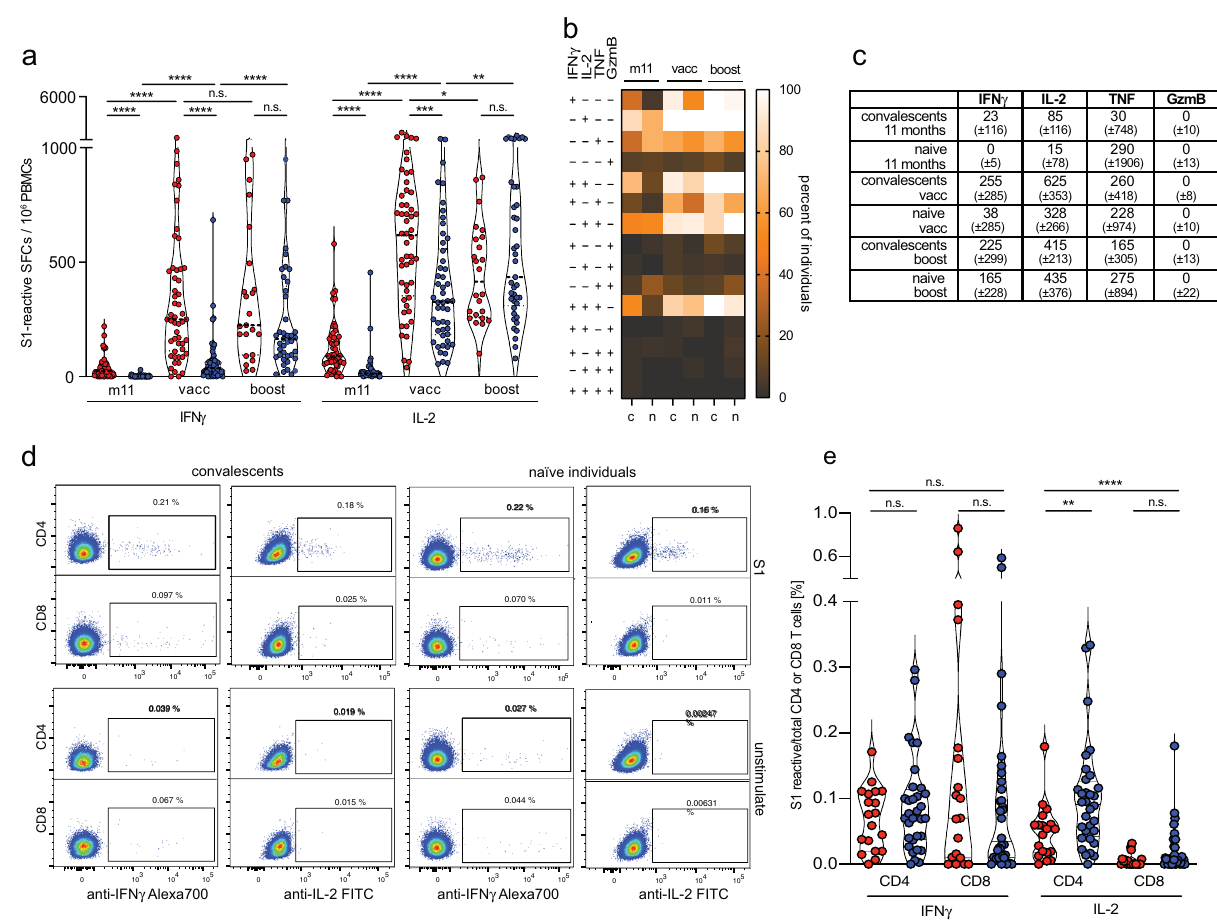
Fig. 5 Rapid induction of polyfunctional IL-2-secreting T cells in convalescents and naïve individuals after BNT162b2 mRNA vaccination. ( a ) frequencies of spike-reactive cytokine-secreting cells in convalescents (red, n = 50 (m11), n = 54 (vacc), n = 23 (boost)), and naïve individuals (blue, n = 39 (m11), n = 49 (vacc), n = 40 (boost)) at month 11 after SARS-CoV-2 infection, two weeks after BNT162b2 mRNA prime vaccination (vacc) and 2 weeks after boost vaccination (boost). b Heatmap revealing frequencies of individuals bearing S1-reactive mono- or polyfunctional cytokine-secreting cells; convalescents (c), naïve individuals (n). c Median and standard deviation for S1-reactive cytokine-secreting cells. d , e S1-reactive IL-2 and IFN γ